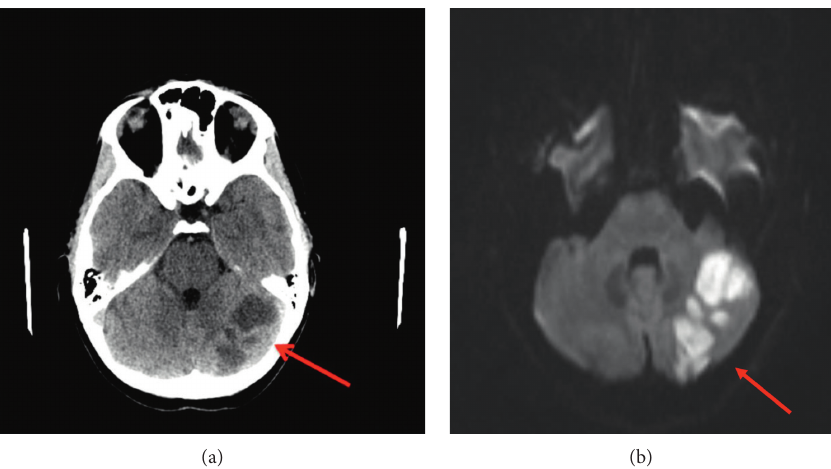
Figure 1: Noncontrast CTof the head (a) and brain MRI-DWI sequence (b) showing several well-circumscribed near fluid attenuation regions in the left cerebellum, the largest of which measures 3.5cm transverse diameter. This is suggestive of left cerebellar ischemic stroke. There is no acute hemorrhage, midline shift, or hydrocephalus.